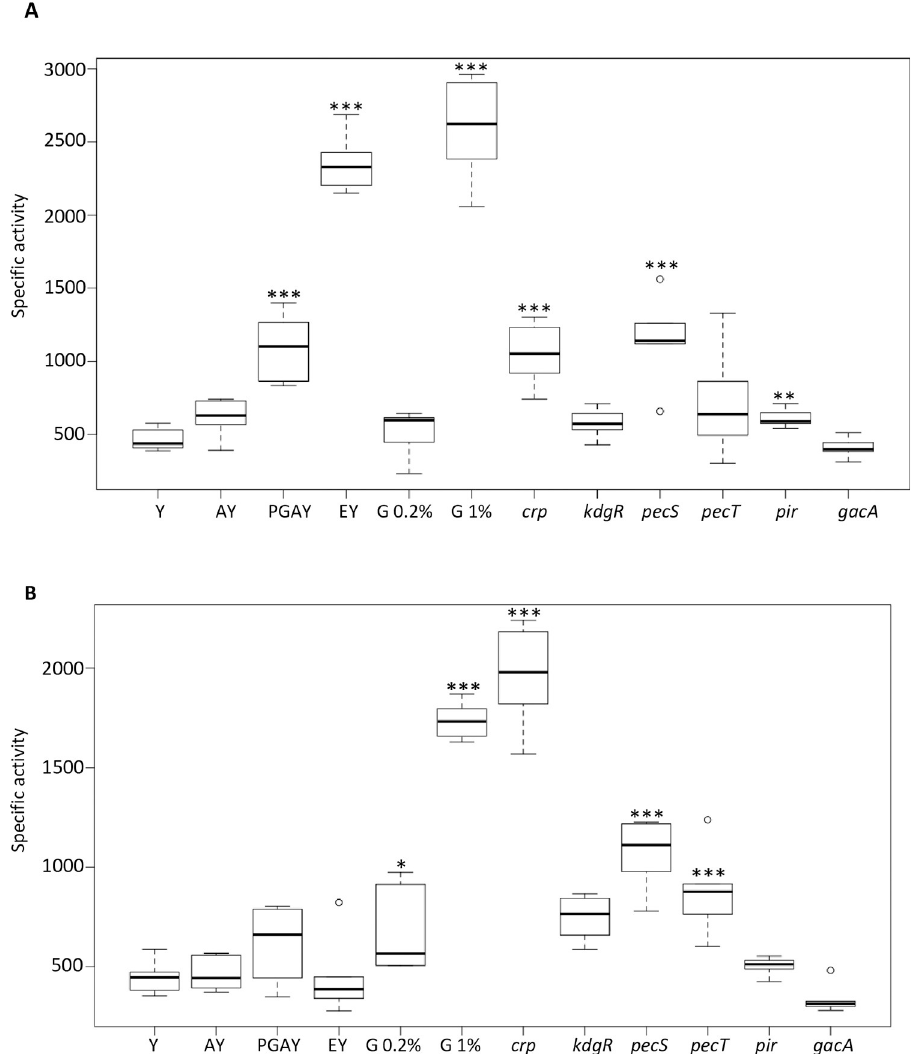
Fig 3. Expression of svfA and svfB in various growth conditions. A. The D . dadantii strain A6418 containing the svfA-uidA fusion and its derivative strains containing an additional regulatory mutation were grown in M63 medium in the presence of the indicated compounds (Y = glycerol, G = glucose, A = galacturonate, PGA = polygalacturonate, E = chicory chunks). Strains with additional mutations were grown with glycerol as a carbon source except the crp mutant that was grown with 0.2% glucose. ß-glucuronidase activity was measured with p -nitrophenyl-ß-D- glucuronate. B. Similar experiment for the D . dadantii strain A6467 containing the svfB-uidA fusion and its derivative strains containing an additional regulatory mutation. Activities are expressed in μ moles of p -nitrophenol produced per minute and per milligram of bacterial dry weight ± standard deviation. Data are expressed as the mean (n = 6) from six independent experiments. Statistical tests were performed using the Wilcoxon- Mann-Whitney test. The p -value were compared with an alpha risk of 4%. p < 0.001 = ��� , p < 0.005 = �� , p < 0.01 = �